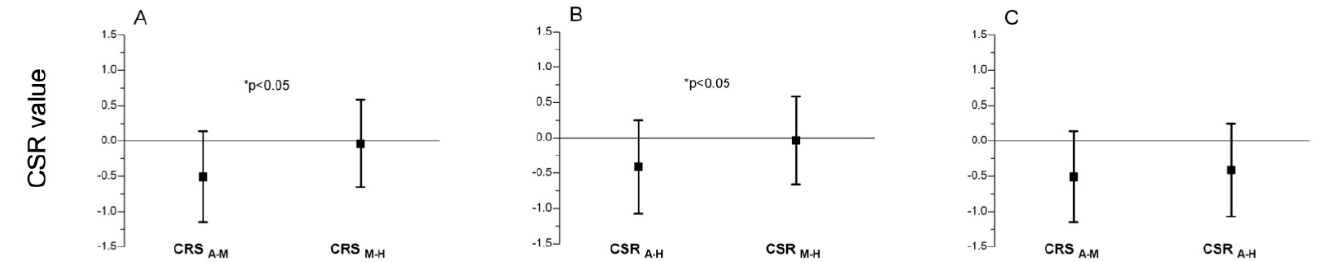
Figure 3. The difference between ( A ) CSR A-M and CSR M-H ; ( B ) between CSR A-H and CSR M-H ; ( C ) between CSR A-M and CSR A-H .